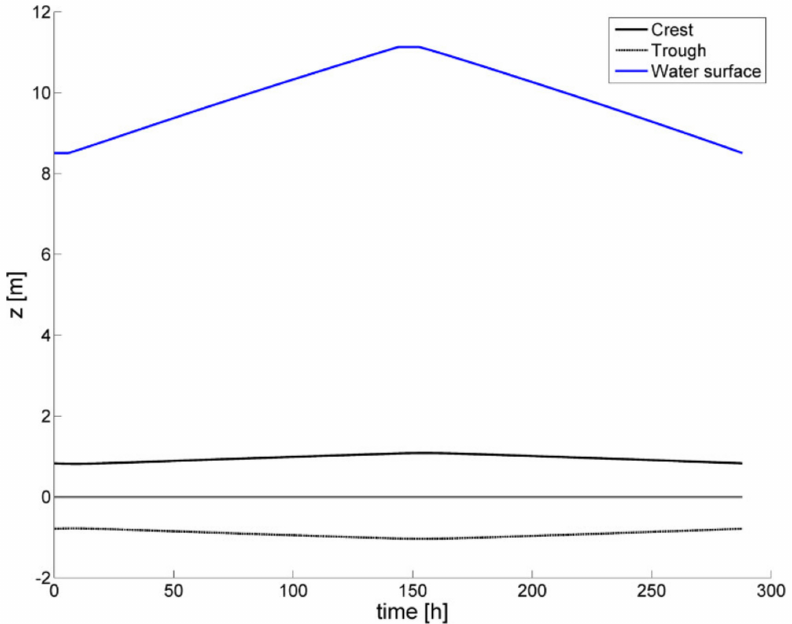
Figure 12. Dune crest and trough position (black lines) and water depth (blue line) over time, using the river scenario.